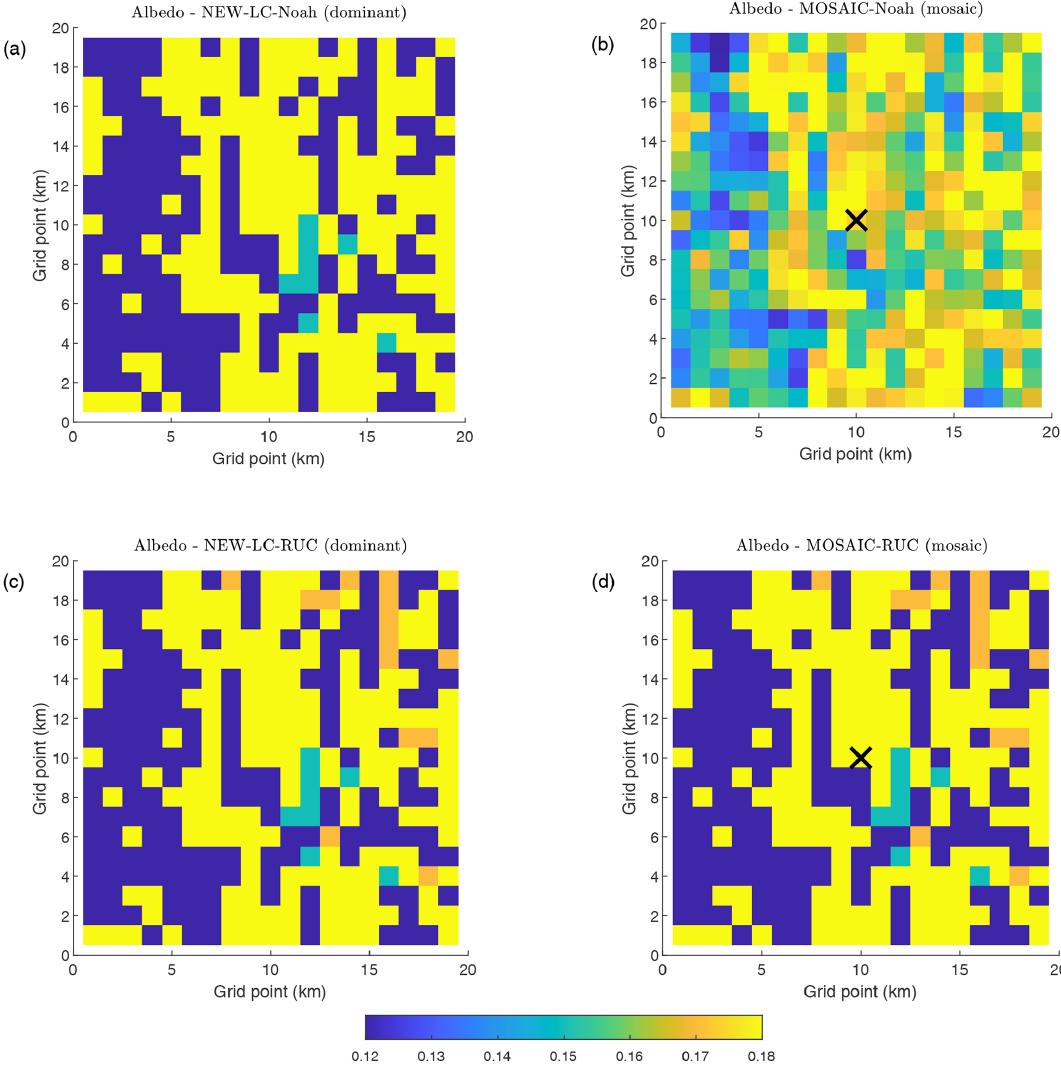
Figure 9. Model albedo over the analysed area. Comparison of the grid values between the dominant (a, c) and the mosaic (b, d) approaches for Noah (a, b) and for RUC (c, d) . Note the absence of change in the mosaic approach using